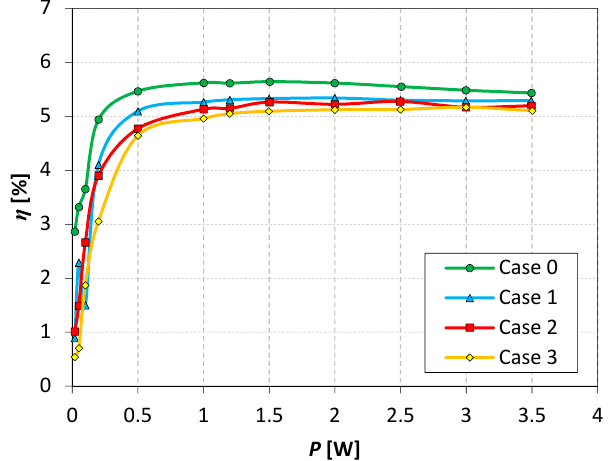
Figure 5. The electrical efficiency of the SJA as a function of real power.